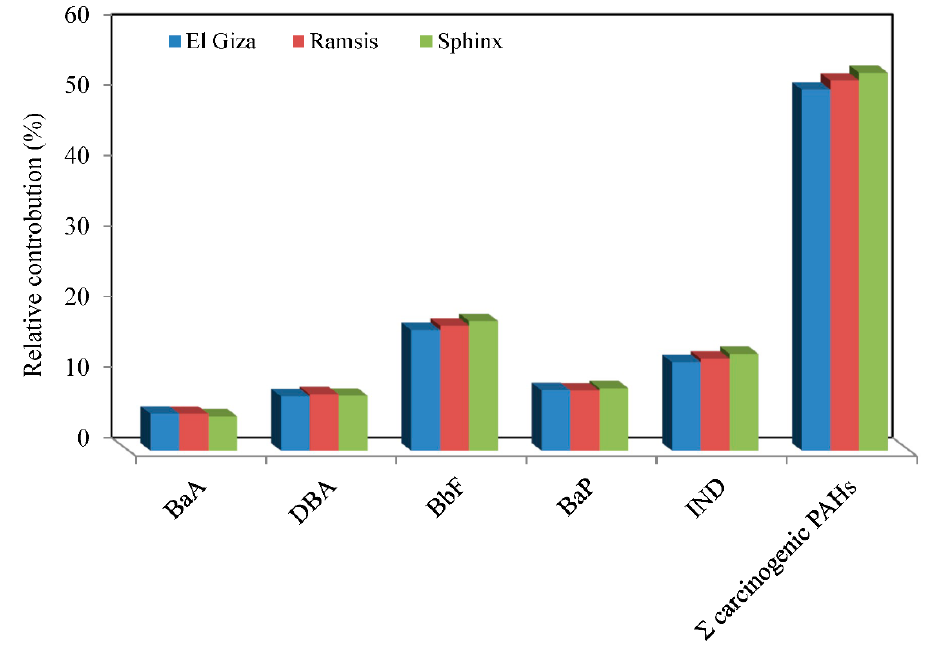
Figure 9. Relative contribution of the carcinogenic PAH compounds to the total concentrations of the PAH compounds at El Giza, Ramsis, and Sphinx Square.